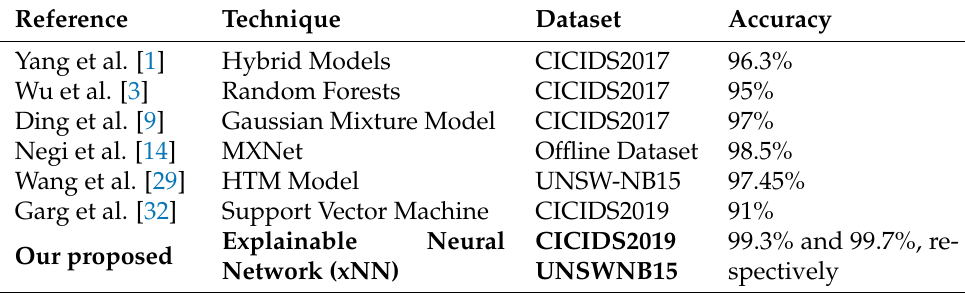
Table 5. Comparative analysis of previous